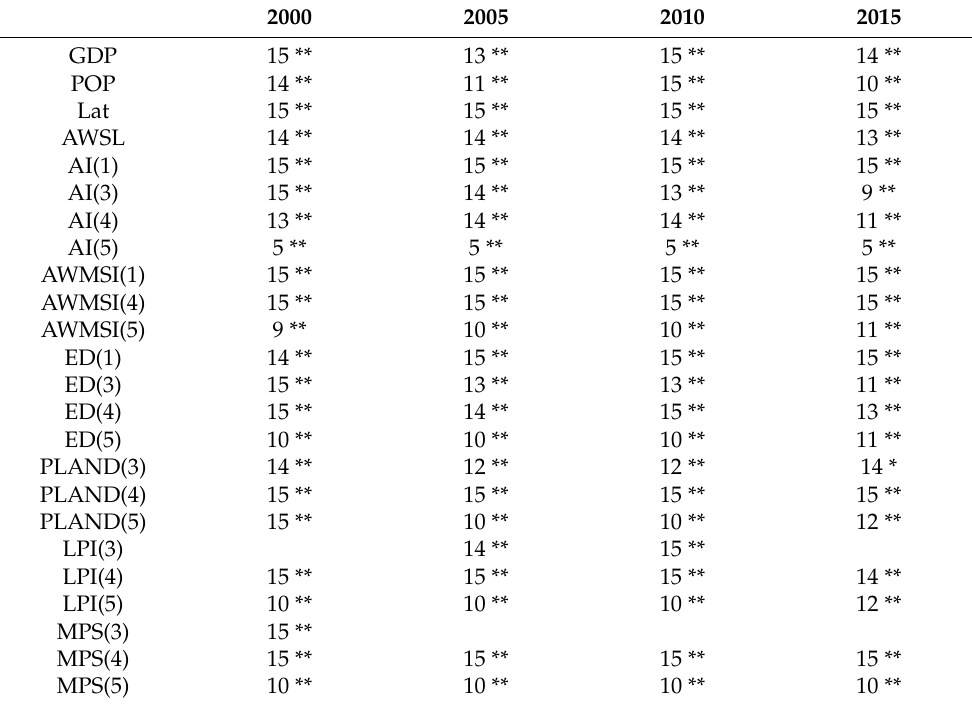
Table A2. The optimal number of categories for discretization of the influence factors of the an-